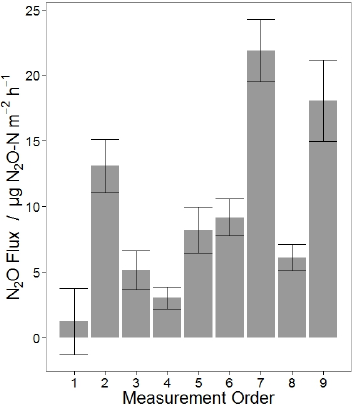
Figure 4. N 2 O fluxes measured from different locations in a drainage stream in the grazed grassland field. Hotspots of N 2 O flux were not observed in the stream measurements. Uncertainty was calculated for each measurement, as was done for the fluxes mea- sured from soils in the field.